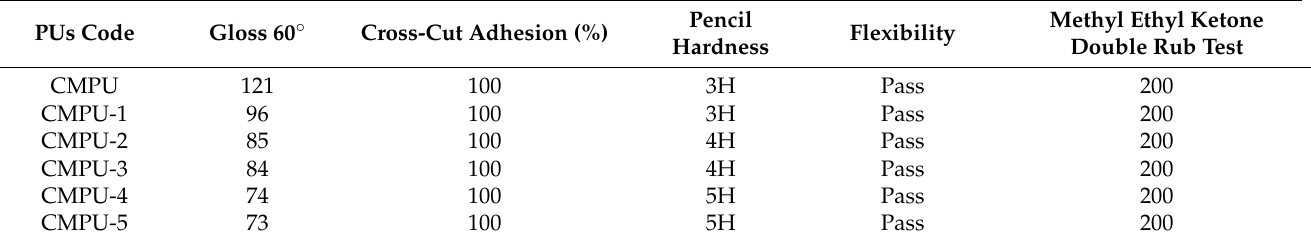
Table 3. Coating properties of prepared PUs coatings.